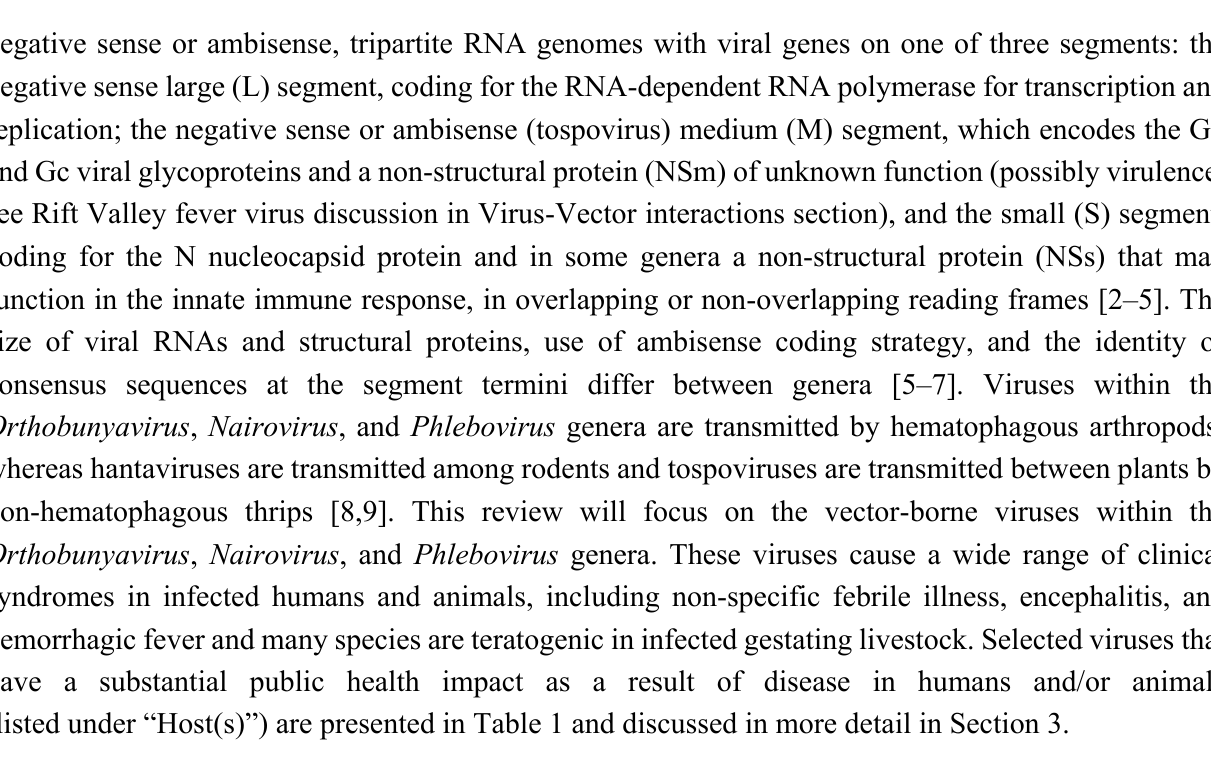
Table 1. Selected medically important vector-borne